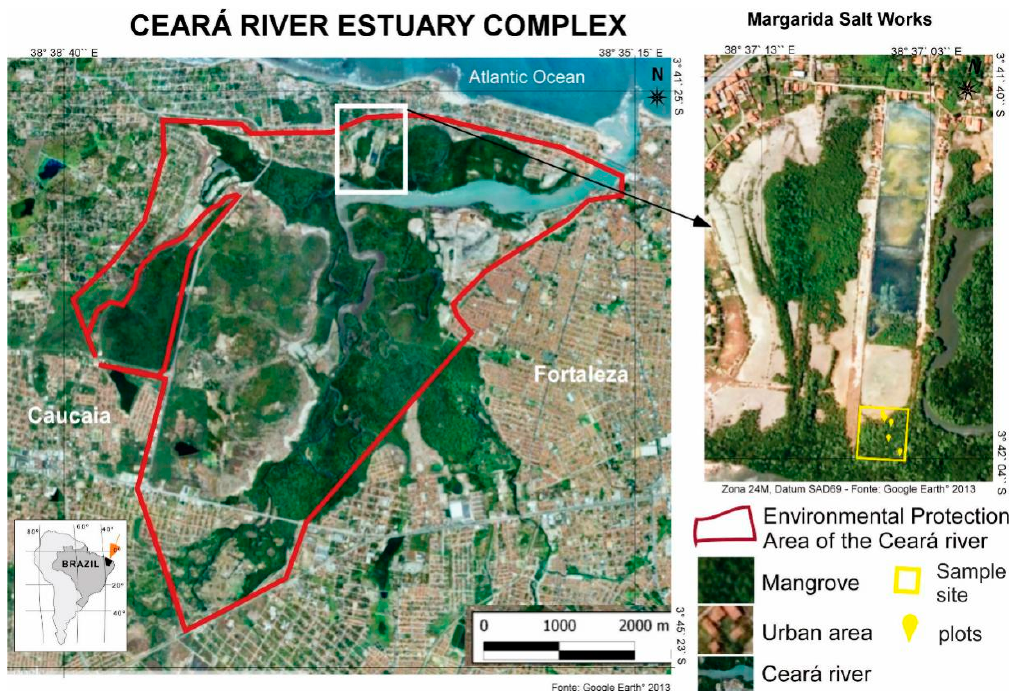
Figure 1. Location of Cear á River estuary, the Margarida salt pond, and the limits of the Cear á River Environmental Protection Area (APA do Rio Cear á ).